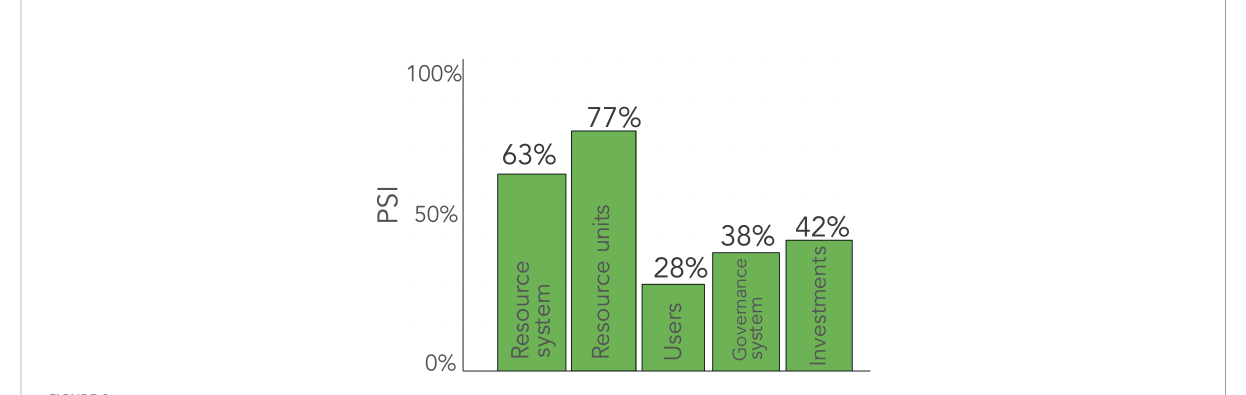
FIGURE 2 Percentage similarity index (PSI) between Isla Todos Santos and Isla Natividad subsystems and investments to management. The PSI value is 0 when there is no similarity and 100% when